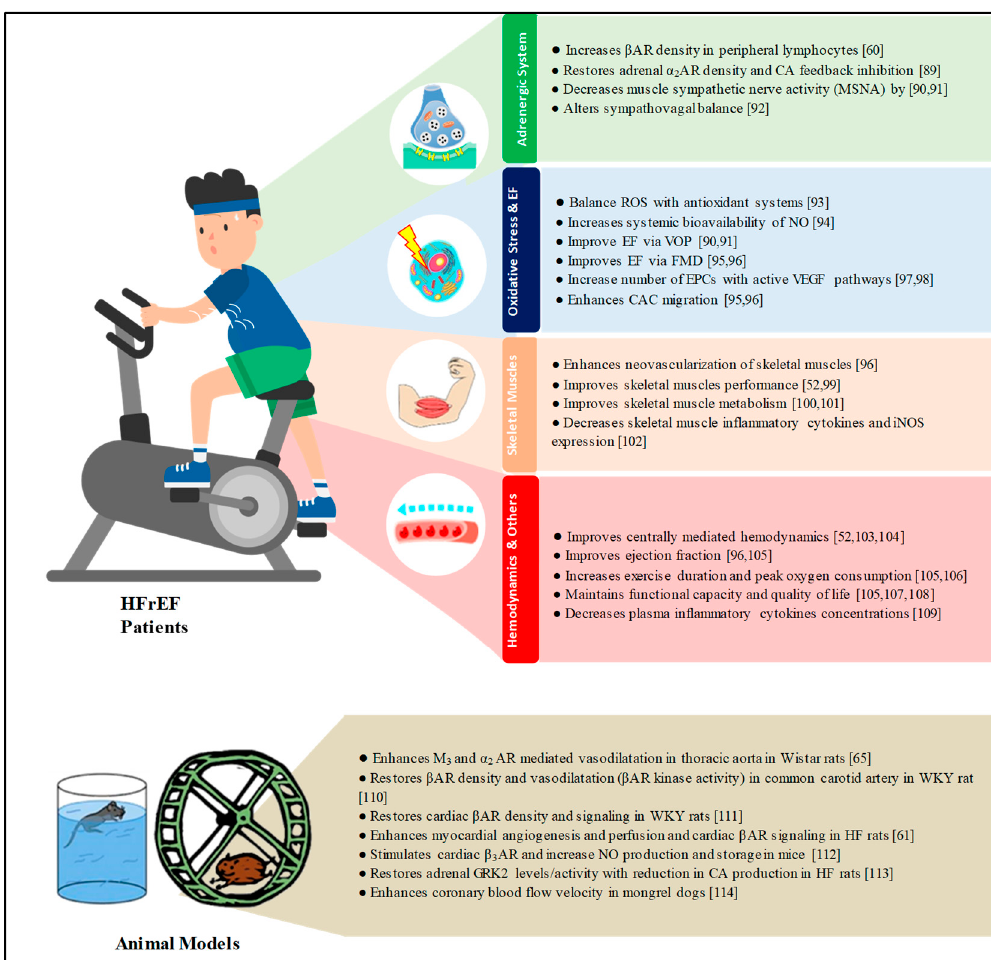
Figure 1. Mechanisms of beneficial effects of physical exercise in HFrEF patients and animal models [89–114]. AR; adrenergic receptors, CA; catecholamines, ROS; reactive oxygen species, NO; nitric oxide, EF; endothelial function, VOP; venous occlusion plethysmography, FMD; flow-mediated dilatation, EPCs; endothelial progenitor cells, VEGF; vascular endothelial growth factor, CAC; circulating angiogenic cells; WKY rats; Wistar–Kyoto rats, HF; heart failure, GRK2; G protein-coupled receptor